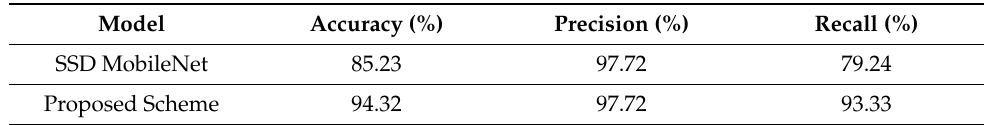
Table 2. Statistical analysis for staircase